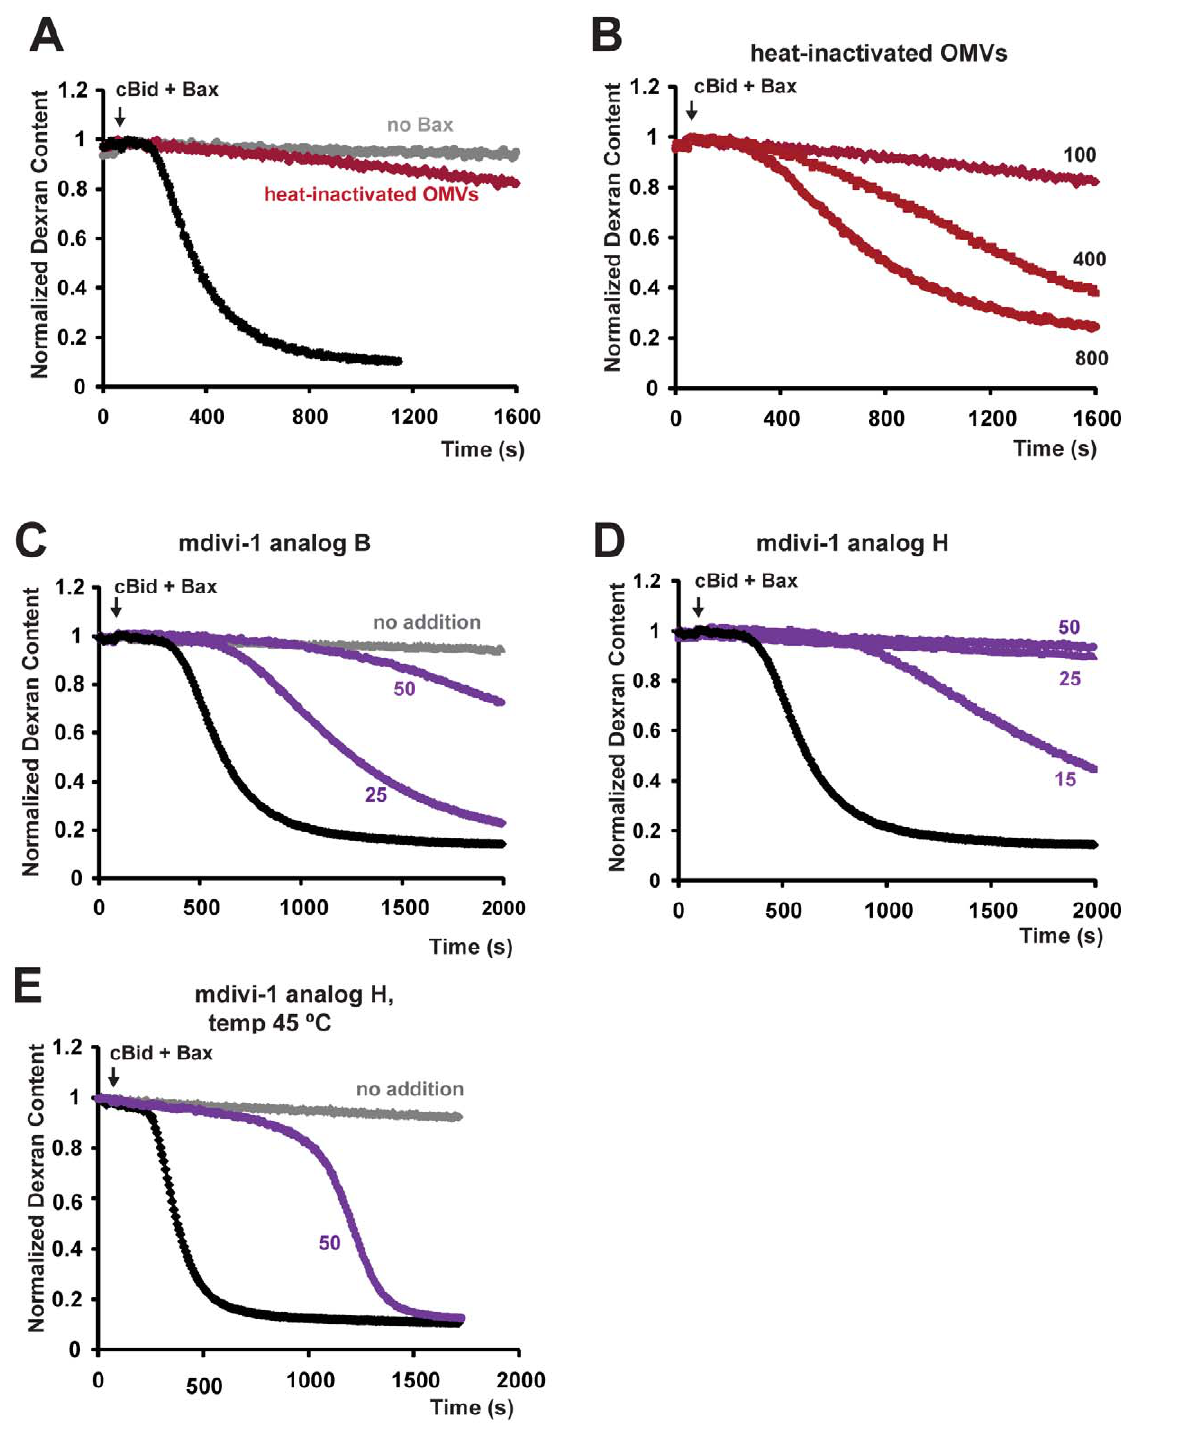
Figure 7. Bax-induced pore formation requires heat-labile protein(s) and is inhibited by mdivi-1 analogs. For heat-induced protein inactivation, OMVs were preincubated at 68 u C for 10 min and equilibrated at room temperature. Dextran-fluorescein release induced by 100 nM Bax in the presence of 40 nM cBid was inhibited in heat-treated OMVs (A), but restored at higher (400–800 nM) Bax concentrations (B). OMVs were incubated with mdivi-1 analogs B and H for 5 min prior to the addition of Bax (C–E). Note that at 25 u C, compound H (25–50 m M) completely inhibits dextran release (D); at 45 u C, however, this compound produces merely a long lag phase without much effect on the rate of pore formation (E). Black lines, control OMVs; red lines, heat-treated OMVs; purple lines, OMVs treated with the mdivi-1 analogs. Arrows indicate additions of Bax; cBid was added 2–3 min prior to Bax. Data shown are representative of at least three independent experiments (see also Figure S6).